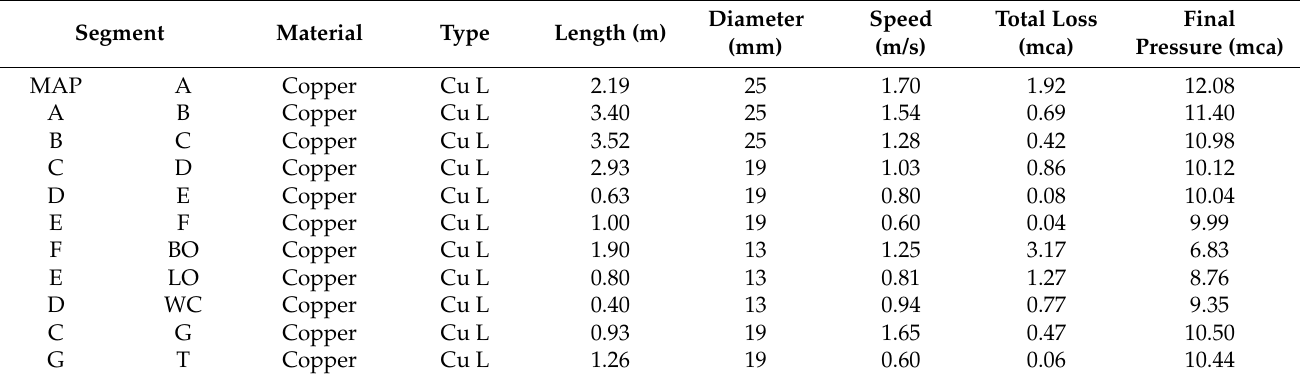
Table 9. Loss summary table for cold-water system in a single-family